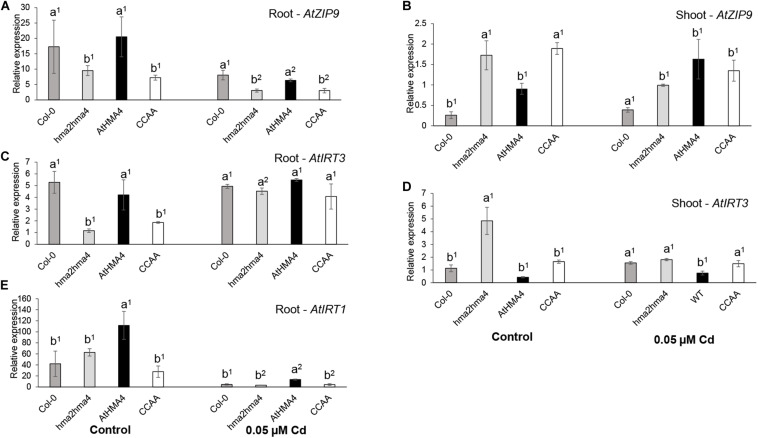
Expression analysis of metal homeostasis genes. AtZIP9
(A,B), AtIRT3
(C,D), and AtIRT1
(E) relative expression levels were measured in root (A,C,E) and shoot (B,D) tissues of wild-type (Col-0), hma2hma4 mutant, and hma2hma4-expressing AtHMA4 or AtHMA4CCAA plants upon hydroponic growth in control conditions (1 μM Zn, no Cd) or exposed for 3 weeks to 0.05 μM Cd. Relative expression values are means ± SEM of three biological replicates each consisting of pools of three plants from two independent lines per genotype. Statistically significant differences (P < 0.05) between genotypes within treatments (one-way ANOVA followed by Tukey’s multiple comparison test) or between treatments within genotypes (t-test for independent means) are indicated by different letters or different superscript numbers, respectively. CCAA: di-Cys → di-Ala motifs.